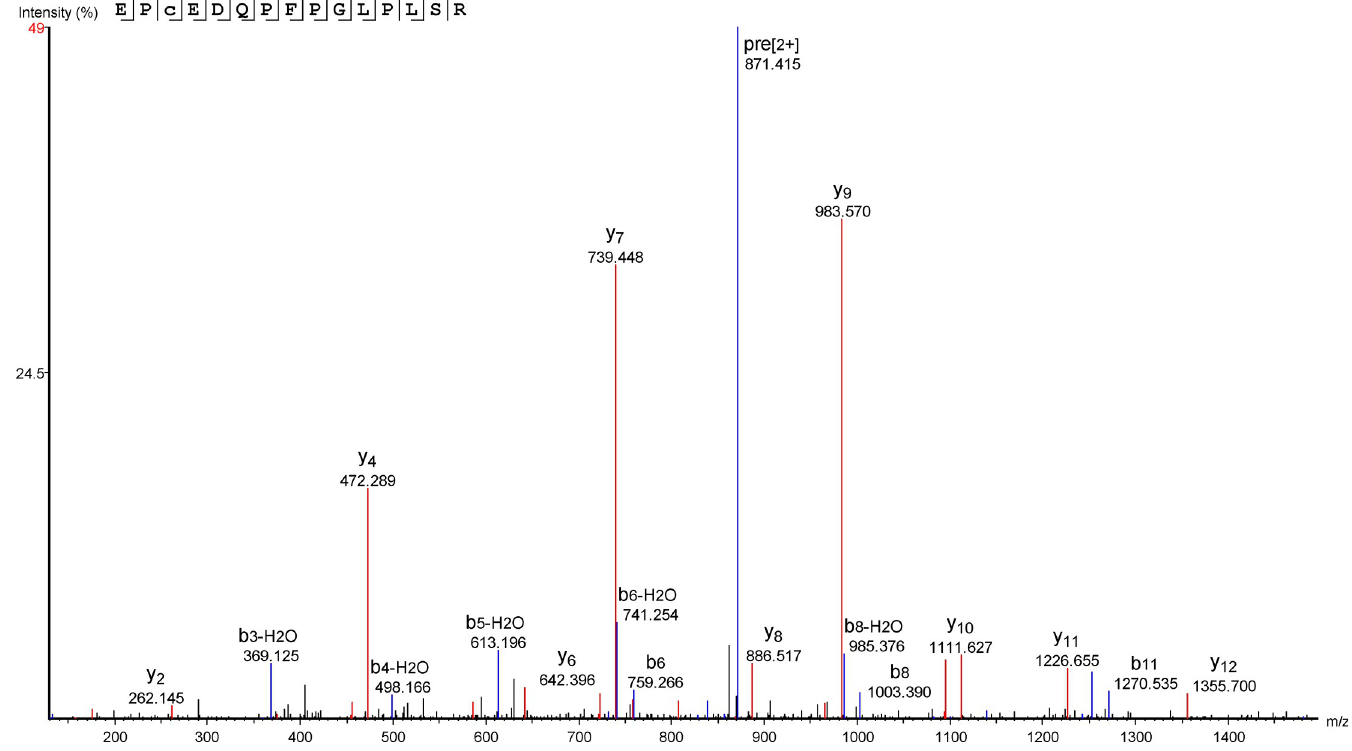
Fig 2. MS/MS spectrum of the Boa γ PLI peptide. Annotated MS/MS spectrum of the tryptic peptide EPCEDQPFPGLPLSR from the Boa γ PLI. The peptide was detected at m/z 871.42 +2 and identified by database search in PEAKS Studio 7.5.